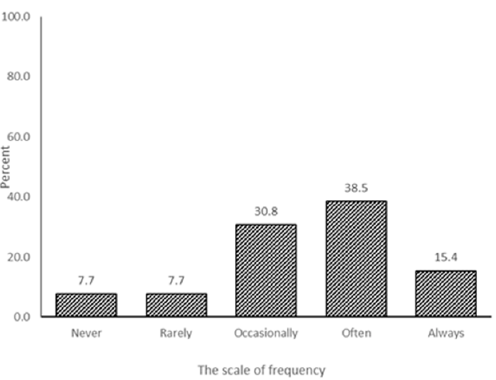
Figure 2. The existing integration of scientific knowledge of the captive species management into the species’ conservation policy and practice.